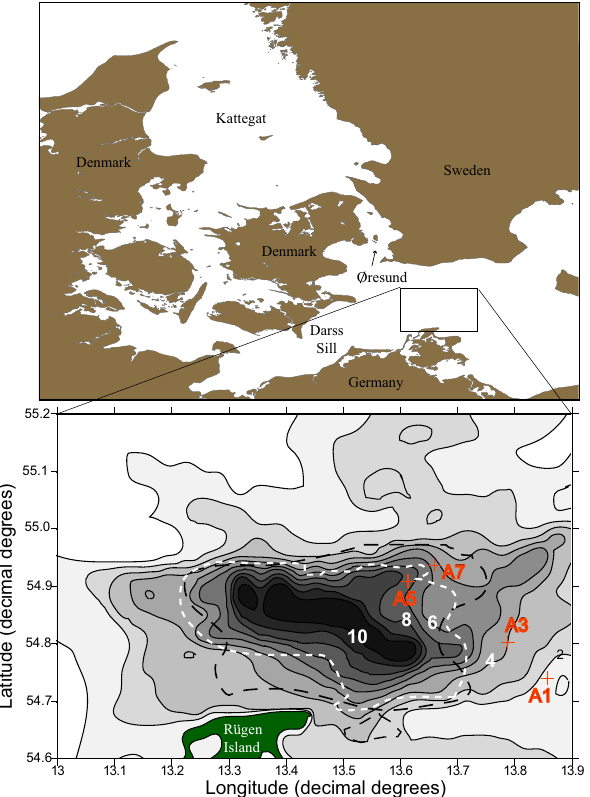
Fig. 1. Station locations within Arkona Basin. The top map shows the location of Arkona Basin with respect to the southwestern Baltic Sea. The lower map shows the Arkona Basin in detail including 1m intervals for the HORM thickness according to Lemke (1998). Superimposed is the spatial extent of free gas according to Laier and Jensen (2007) – black dashed line, and Thießen et al. (2006), white line.